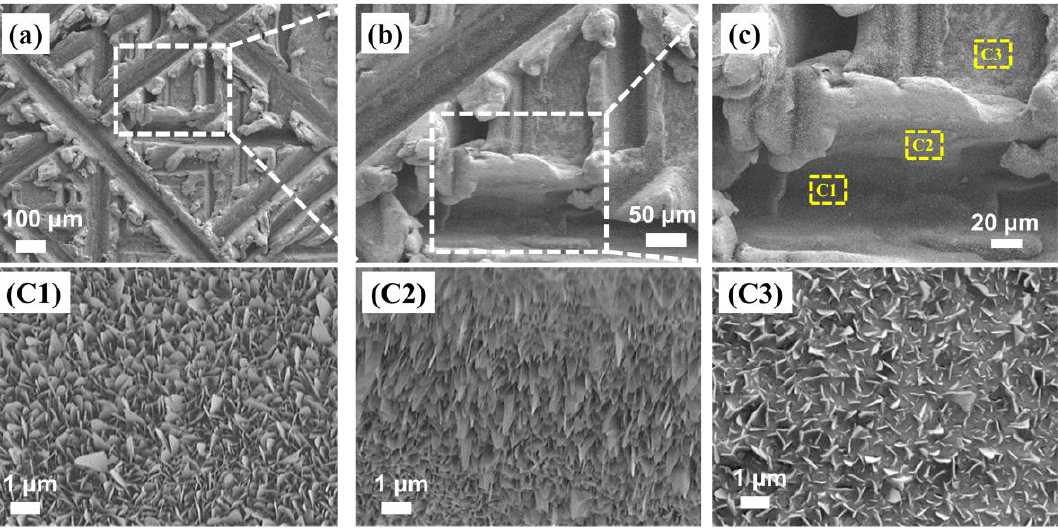
Figure 2. ( a ) SEM images of FAS-13-modified superhydrophobic iron; ( b ) enlarged image in corre- sponding box of ( a ); ( c ) enlarged image in corresponding box of ( b ); ( C1 – C3 ) enlarged images in corresponding boxes of ( c ).